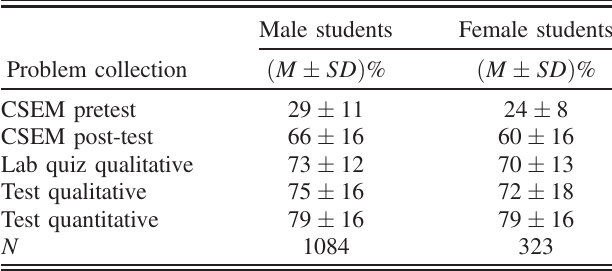
TABLE II. Male and female student averages for different problem collections.